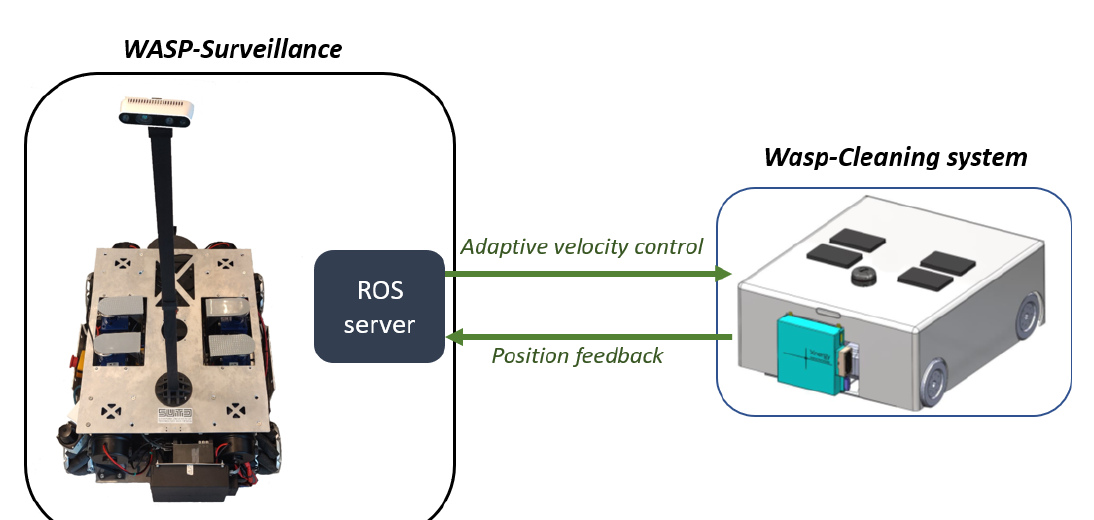
Figure 3. WASP with cleaning